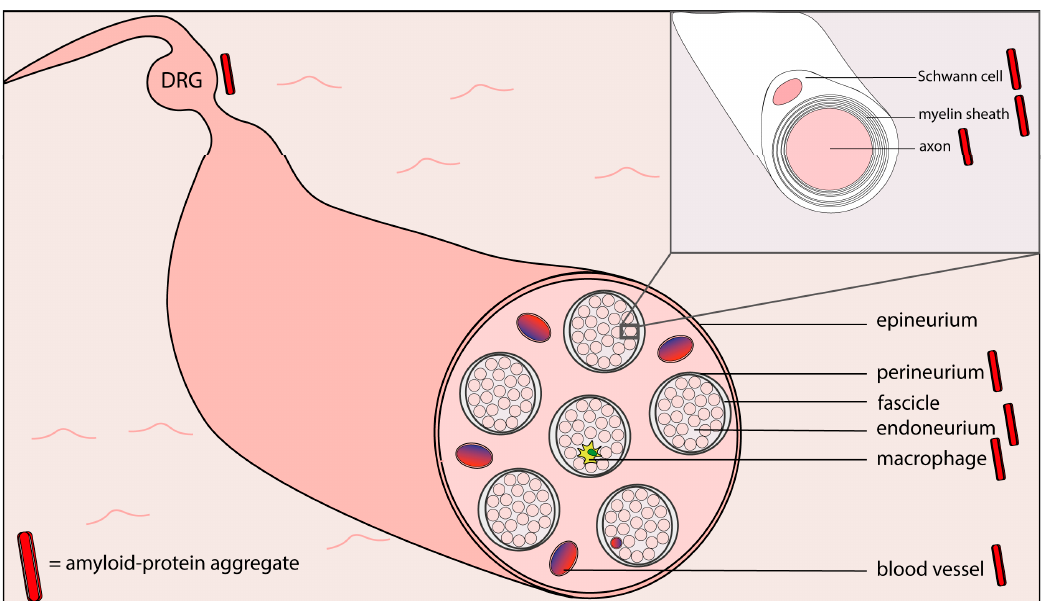
Figure 2. Schematic representation of the ultrastructure of a peripheral sensory nerve, with locations where amyloid or amyloid protein aggregates have been demonstrated indicated by a red bar (based on references [73–81]). DRG = dorsal root ganglion.